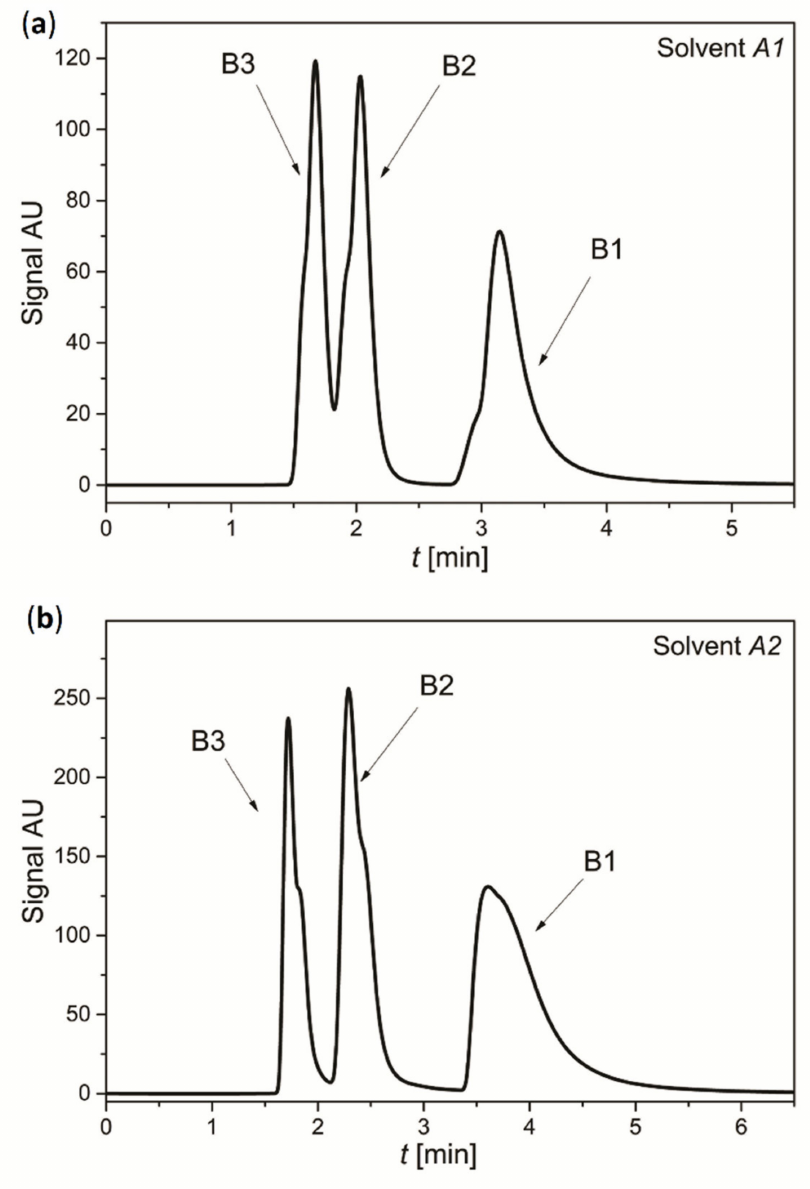
Figure 14. Separation of vitamin mixture obtained using column A and solvent: ( a ) A 1 and ( b ) A 2 as mobile